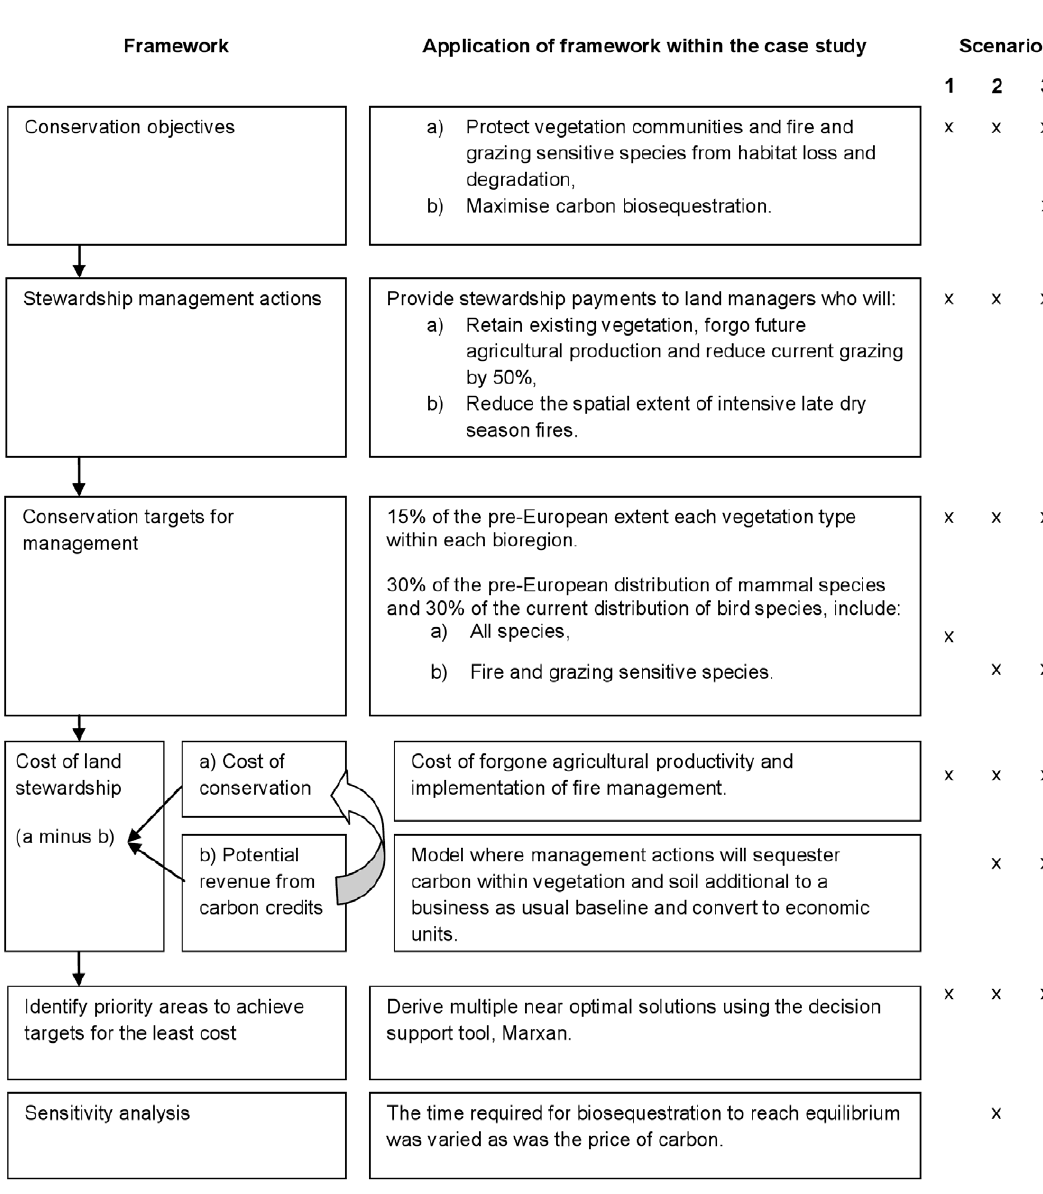
Figure 1. A framework to prioritise stewardship payments for improved land management while accounting for potential carbon revenue. Application of the framework to three scenarios in the context of Australia’s northern savannas is described.